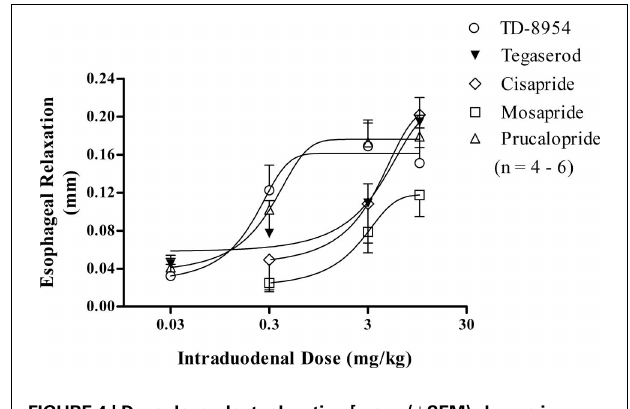
FIGURE 4 | Dose-dependent relaxation [mean ( ± SEM) change in inter-crystal distance (in mm)] of the rat esophagus following i.d. administration ofTD-8954 (0.03–10mg/kg; n = 4), prucalopride (0.03–10mg/kg; n = 4), tegaserod (0.03–10mg/kg; n = 6), cisapride (0.3–10mg/kg; n = 4), and mosapride (0.3–10mg/kg; n =